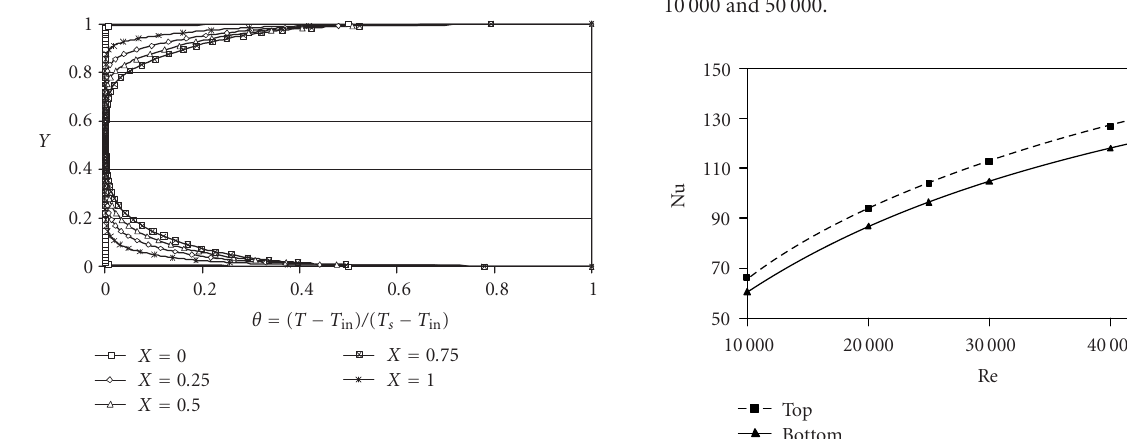
Figure 16: Average Nusselt distribution over the top and bottom walls of the cooling channel for ˙ m r = 1 / 2 and di ff erent Reynolds